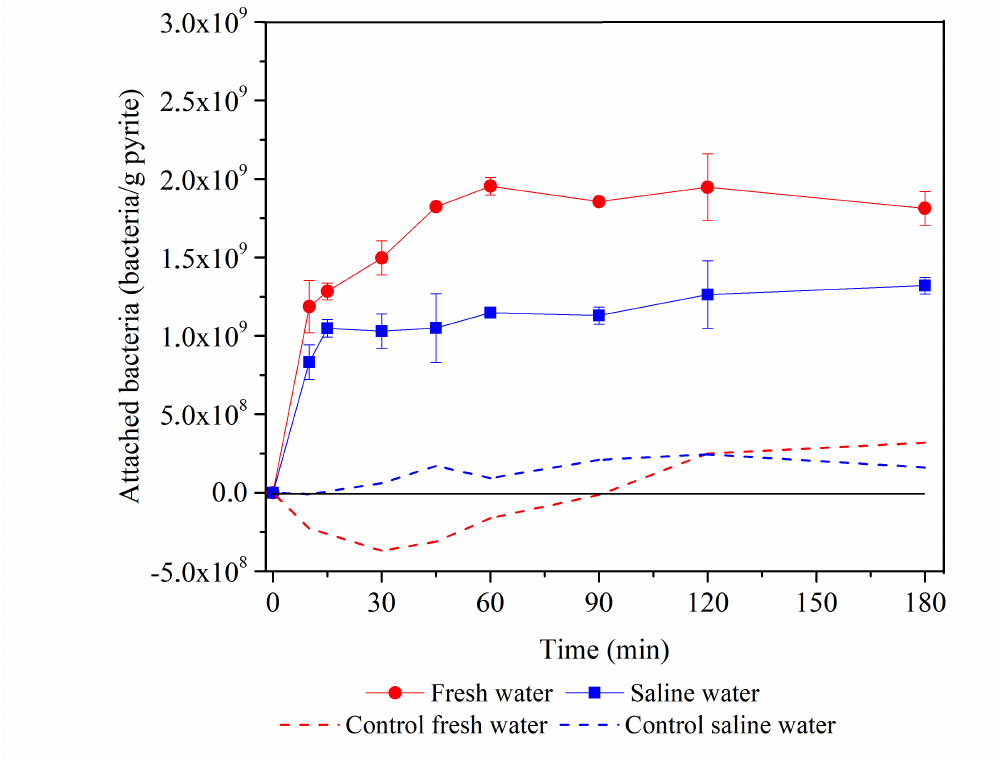
Figure 1. Attachment kinetics of A. ferrooxidans to pyrite in fresh and saline water (35g/L NaCl or 0.6M). The controls were experiments without minerals (only bacteria and